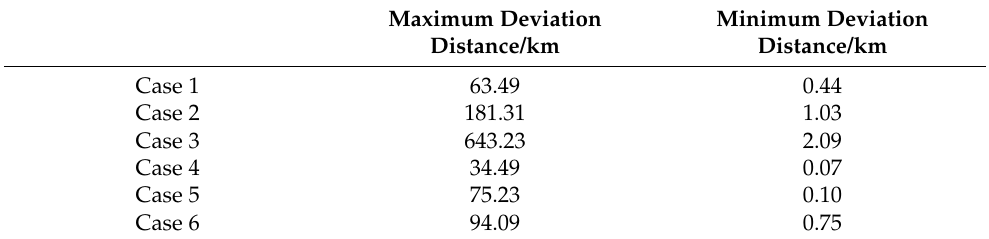
Table 1. The maximum and minimum deviation distances for six cases is with five stations.